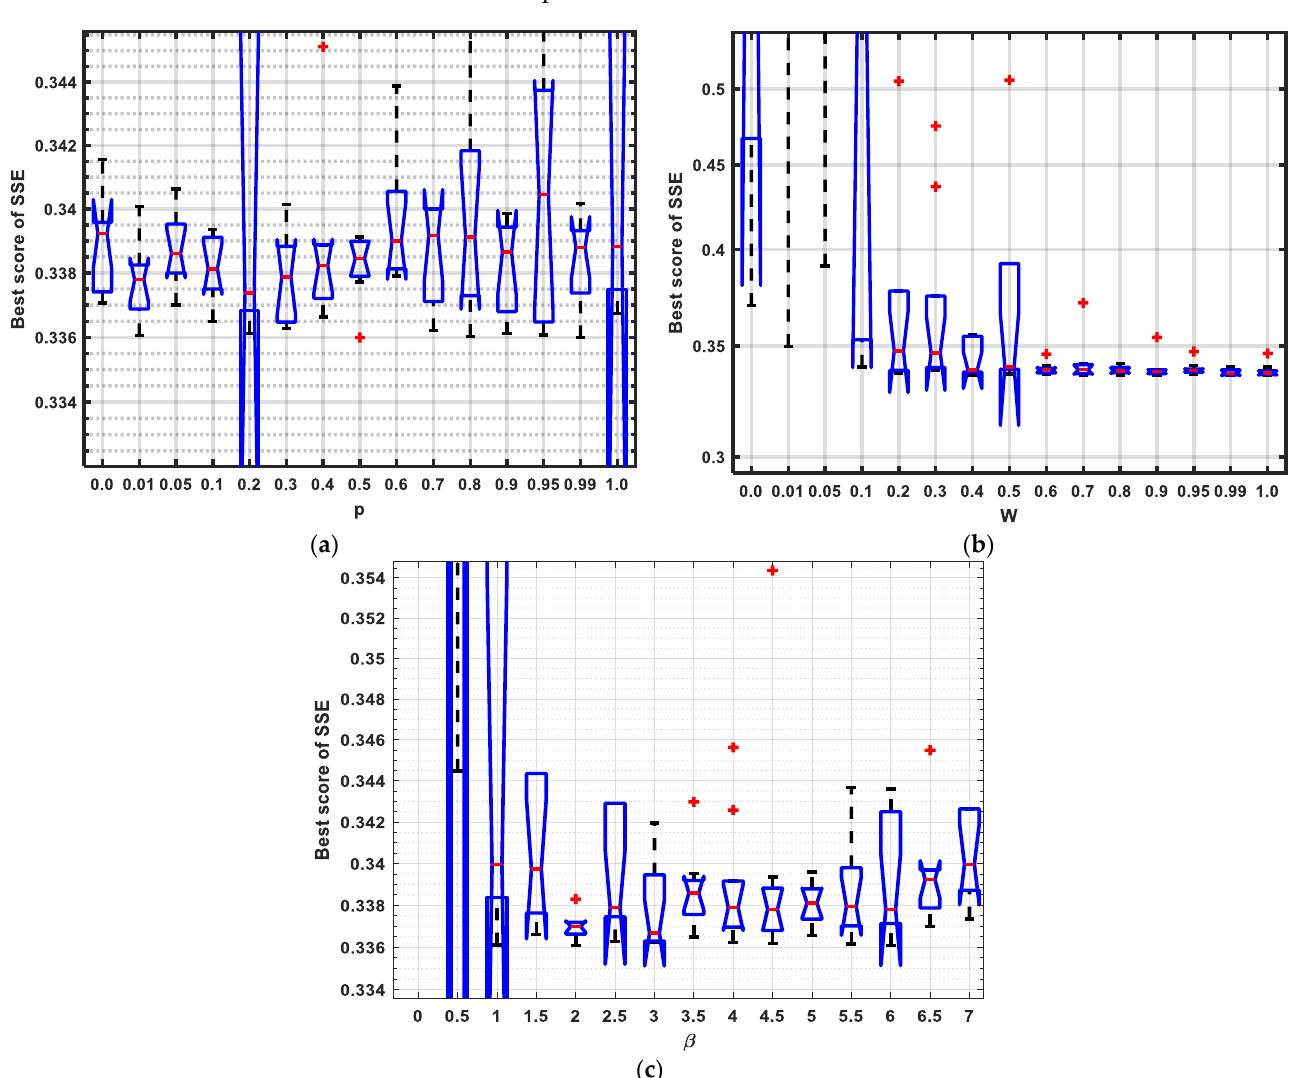
Figure 3. Tuning the parameters of GTO: ( a ) tuning the parameter p, ( b ) tuning the parameter W , ( c ) tuning the parameter β 𝛽 .